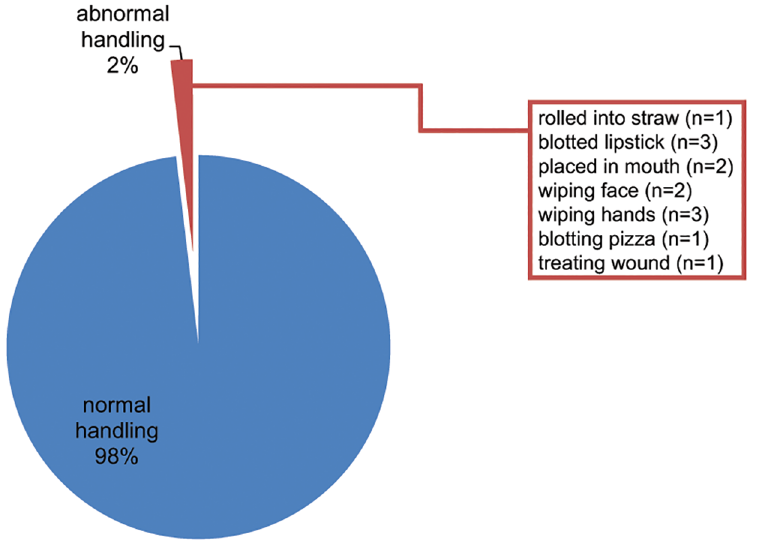
Fig 2. Abnormal handling parameters were observed in ~2% of study participants. Typical handlingof thermal paper involvescontact of only the hands (fingertips and palm) with the paper. Atypical handling patterns were observedin 13 individualsas indicatedin the figure.